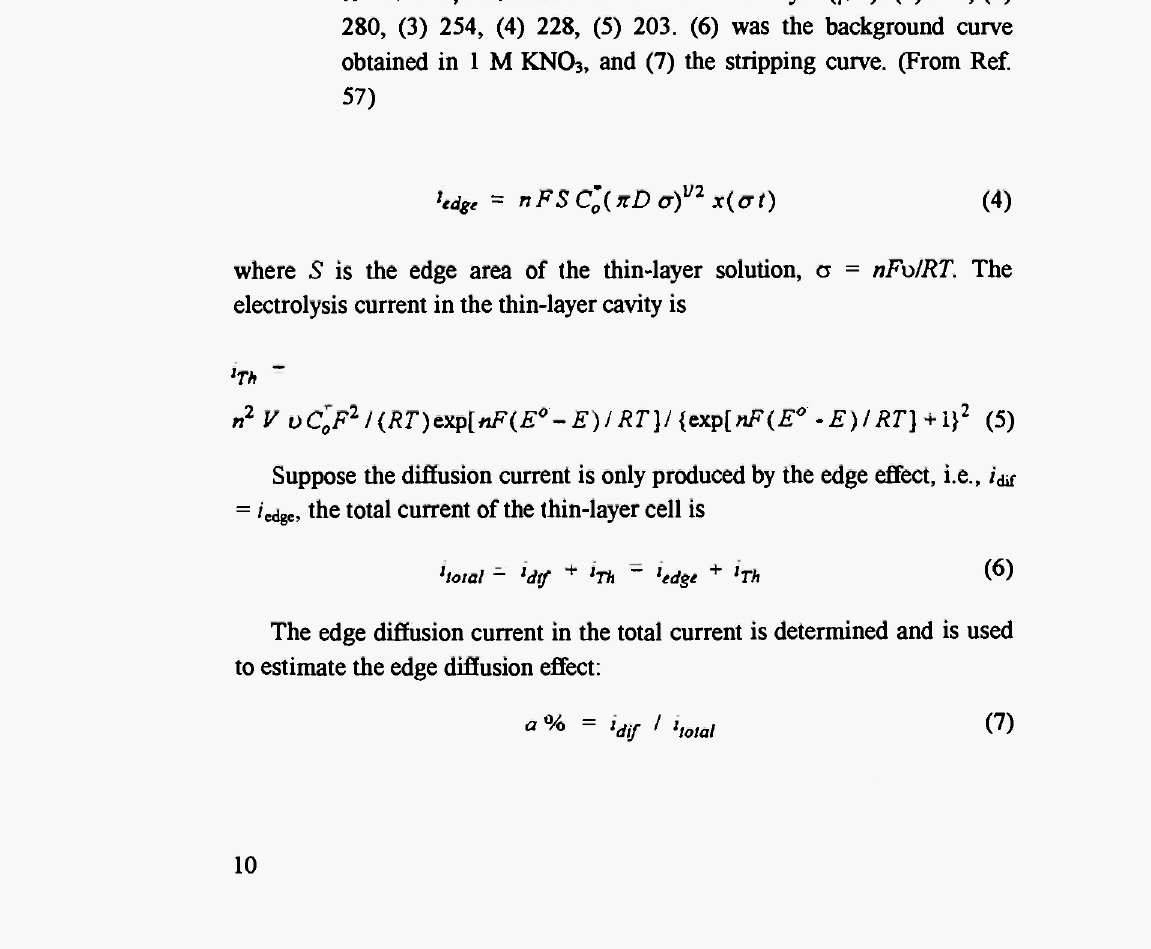
Fig. 3: Q -1 curves of Cu 2+ at Hg deposited Pt electrode. Solution: 1.04 mM Cu 2+ + 1 Μ KNOj, potential step amplitude: +0.15 to -0.20 to +0.15 V; thickness of the thin solution layer (μιη): (1) 305, (2) 280, (3) 254, (4) 228, (5) 203. (6) was the background curve obtained in 1 Μ KNO3, and (7) the stripping curve. (From Ref.